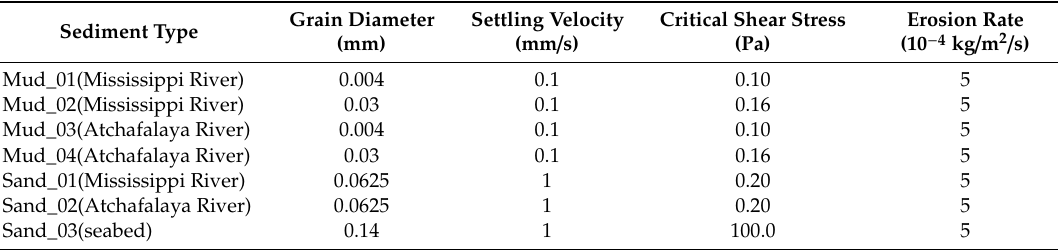
Table 1. Sediment characteristics